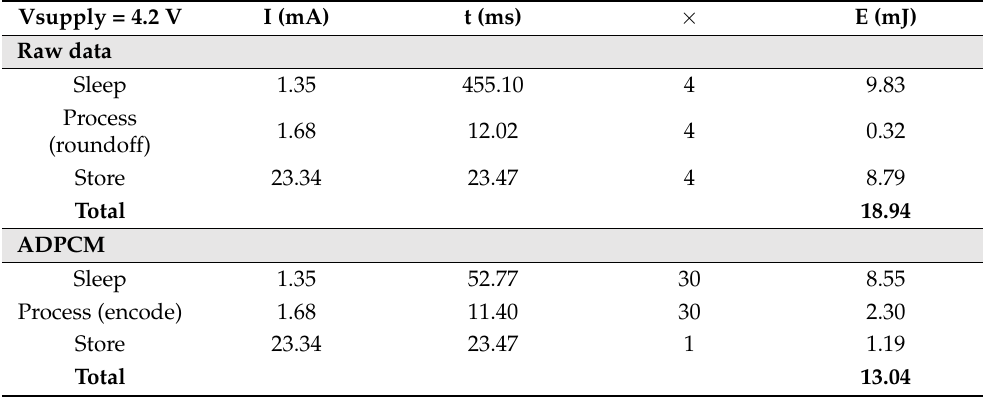
Table 2. Energy required for a 2 s recording without and with embedded ADPCM compression.